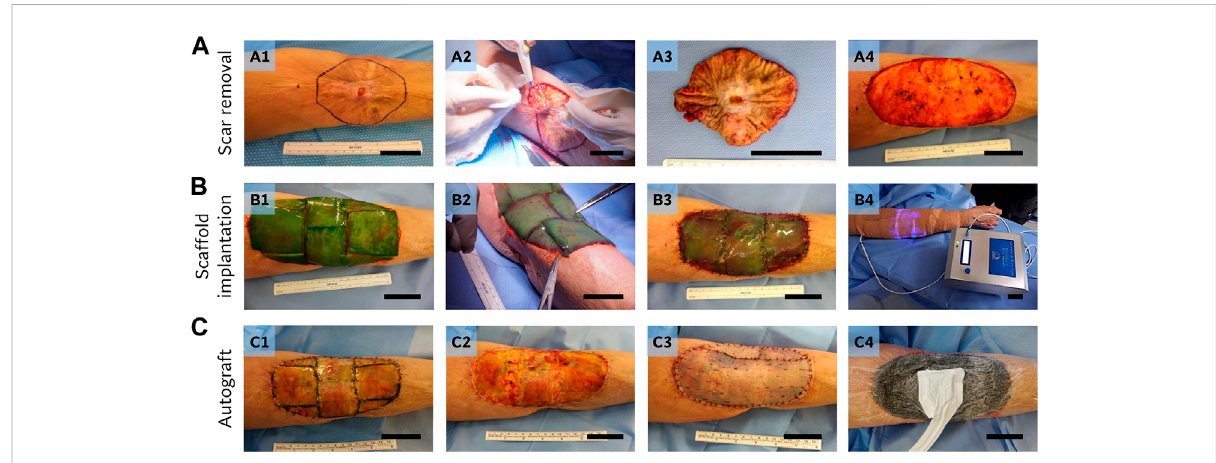
FIGURE 2 Surgicalprocedures.Scarremoval (A) :edgesweremarkedpriortoresection(A1),andacompletescarexcisionwasperformed(A2-3),exposing thesubcutaneous adiposetissueand the fi nalsize ofthedefect (A4).Scaffold implantation (B) : fi vesheets ofphotosyntheticscaffold (5× 5 cmeach) were required to cover the wound (B1), being cut- fi tted, and fi xed to the defect with non-absorbable sutures (B2-3). Finally, scaffolds were covered with a sterile dressing and the illumination device was placed on top (B4). Autograft (C) : 21 days after implantation, no signs of rejection, in fl ammation or infection were detected in the scaffolds, and a loss of the characteristic initial green color of the scaffold was observed (C1). After removal of the silicon layer (C2), an autograft was implanted (C3) and negative wound therapy was applied (C4). Scale bar represents 5